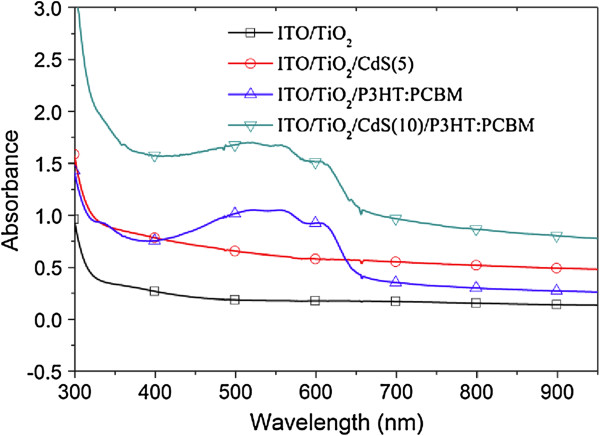
UV–vis absorption spectrum of the ITO/nc-TiO2, ITO/nc-TiO2/CdS(5), and ITO/nc-TiO2/CdS(n)/P3HT:PCBM films (n = 0 and 10).